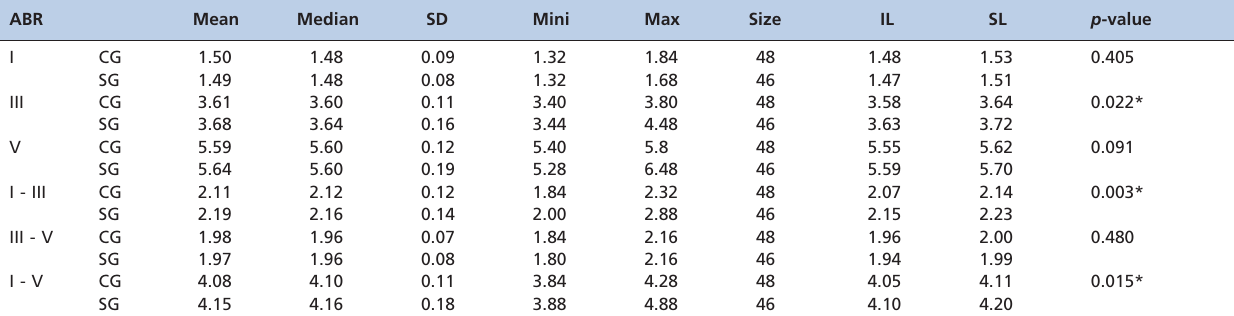
Table 1 - Control (CG) and study (SG) group comparisons regarding the wave I, III, and V and I-III, III-V, and I-V interpeak ABR